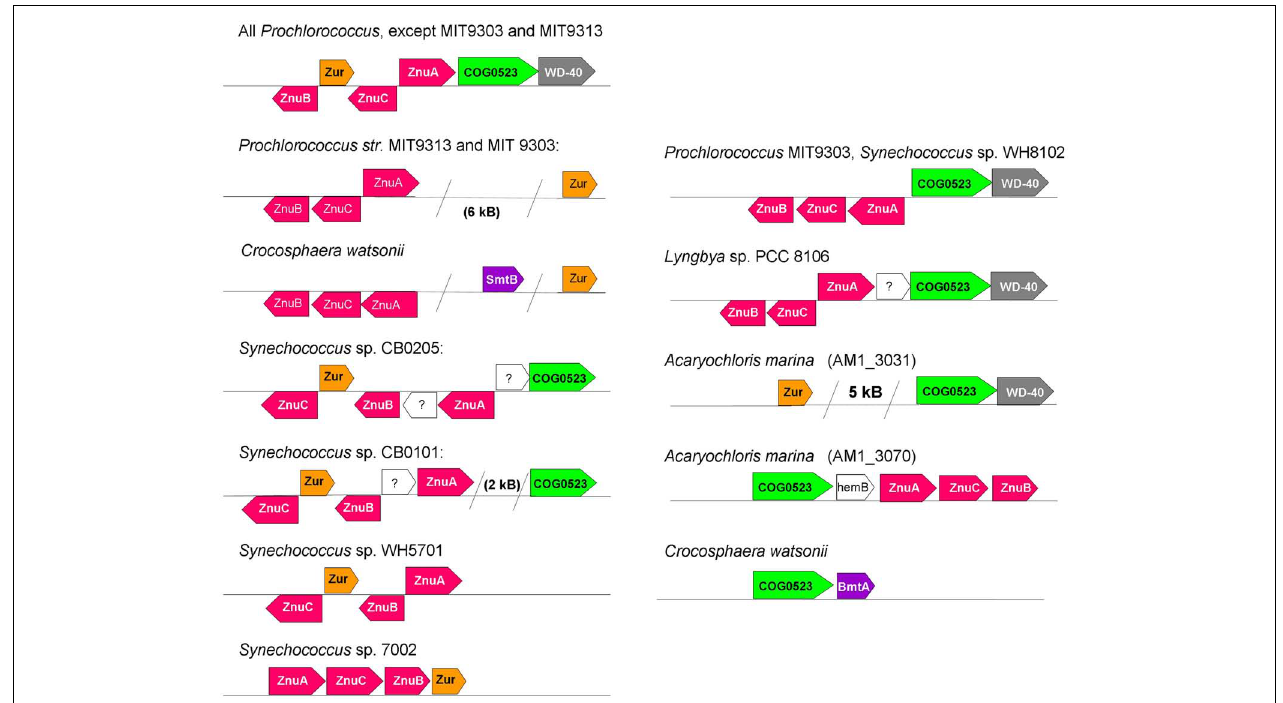
recognizable elements of zinc homeostasis. Note that there appear to be two ZnuABC-type systems in Prochlorococcus marinus sp. MIT 9303.The Acaryochloris marina genome and plasmids harbor at least nine COG0523 family members; AM1_3070 (corresponding to UniProt entry B0CDJ7_ACAM1) and AM1_3031 (corresponding to UniProt entry B0CCJ8_ACAM1) are directly or indirectly associated with zinc